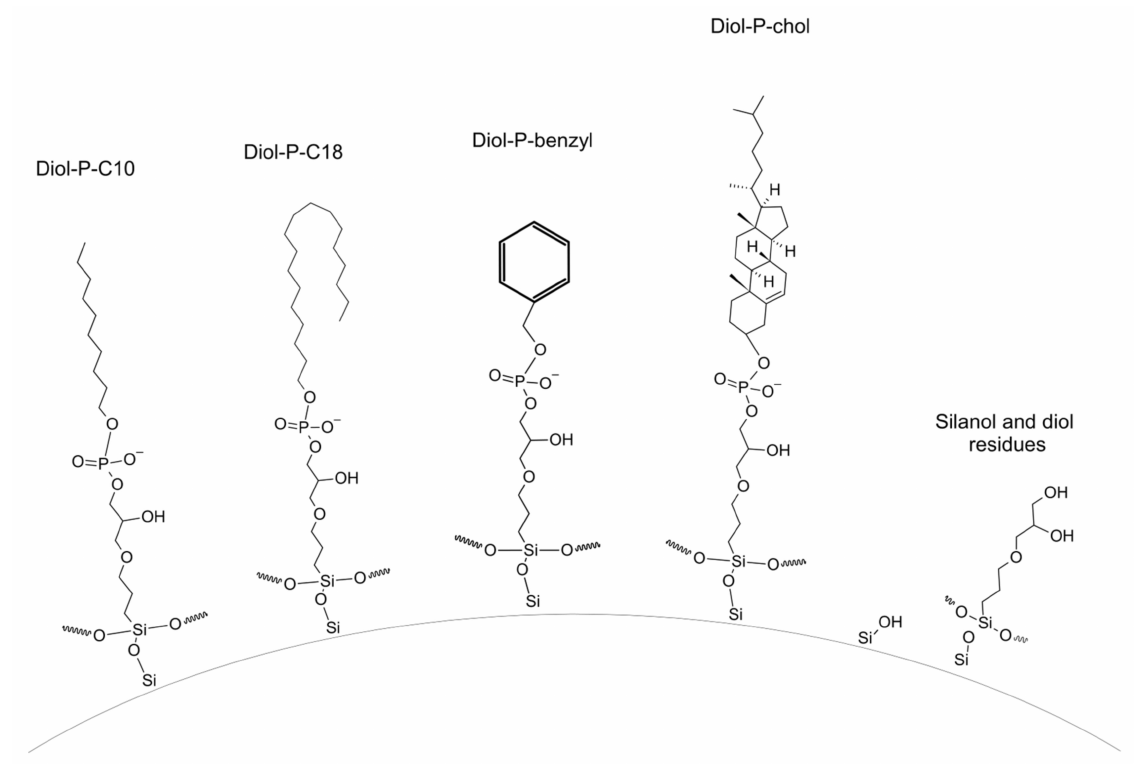
Figure 1. Structures of chemically bonded stationary phases used in the study at pH = 7.5.